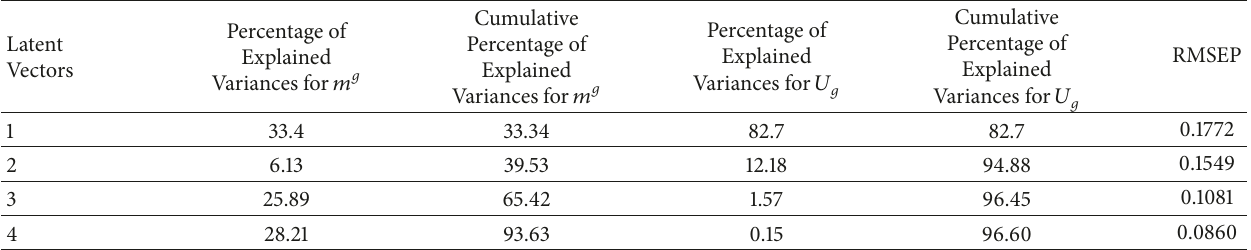
Table 5: Variance of 𝑚 𝑔 and 𝑈 𝑔 explained by the latent vectors and RMSEP for Ghana.